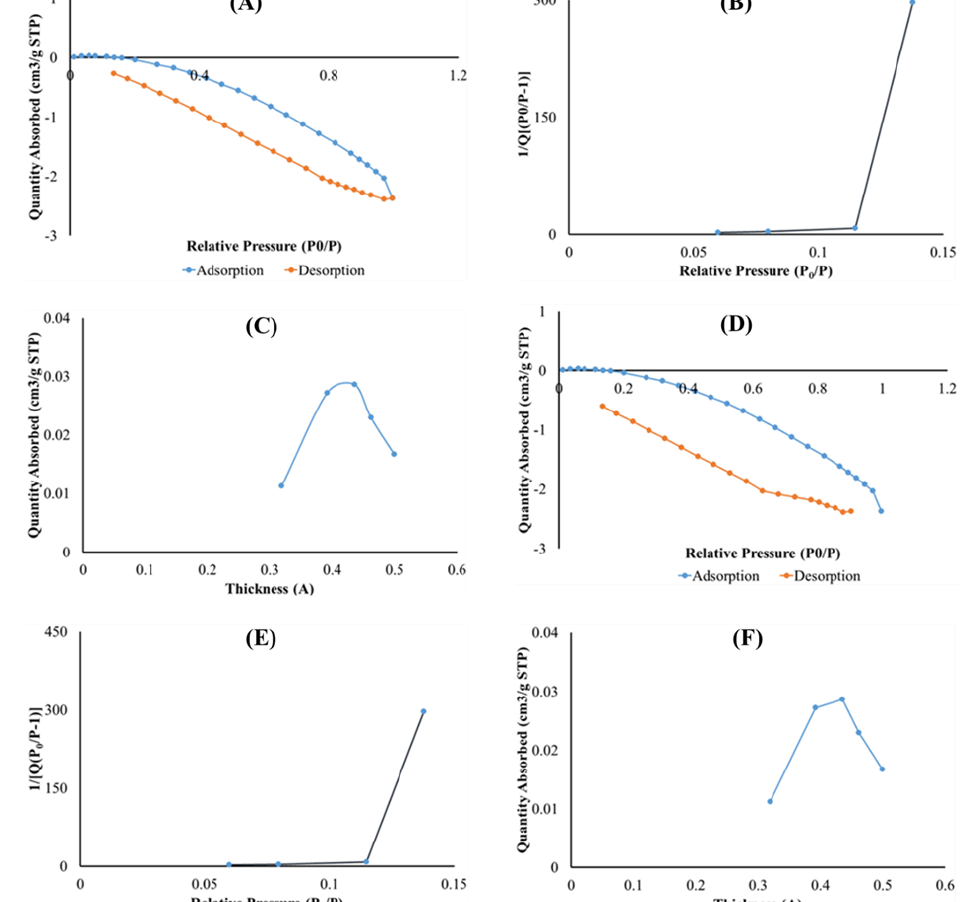
Figure 7. Graph presentation of Isotherm liner plot of ( A ) drug loaded and ( B ) placebo, BET surface area plot for ( C ) drug loaded and ( D ) placebo and t-plot of ( E ) optimized drug loaded and ( F ) placebo.